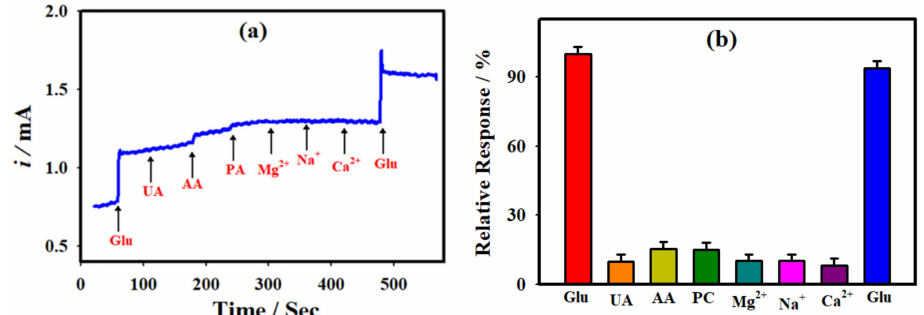
Figure 5. ( a ) CA i-t curve of NC-NiS@NS-NiS|NF electrode recorded in 1.0 M KOH with the addition of 100 µ M glucose, 1.0 mM UA, 1.0 mM AA, 1.0 mM PA, 1.0 mM Mg 2+ , 1.0 mM Na + , 1.0 mM Ca 2+ and 100 µ M glucose at E app : 0.5 V. ( b ) The measured relative response of the NC-NiS@NS-NiS|NF electrode in the presence of various